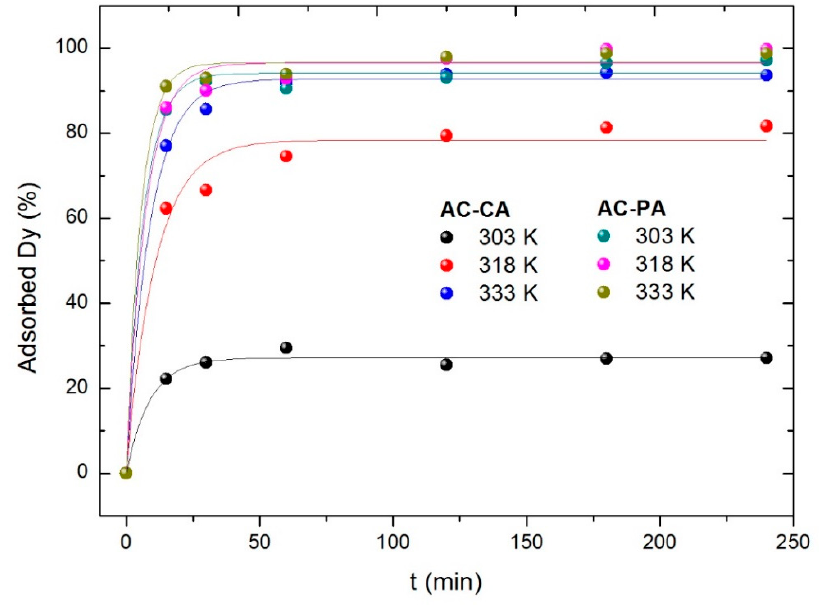
Figure 8. Dysprosium (Dy) adsorption percentage with the temperature variation.